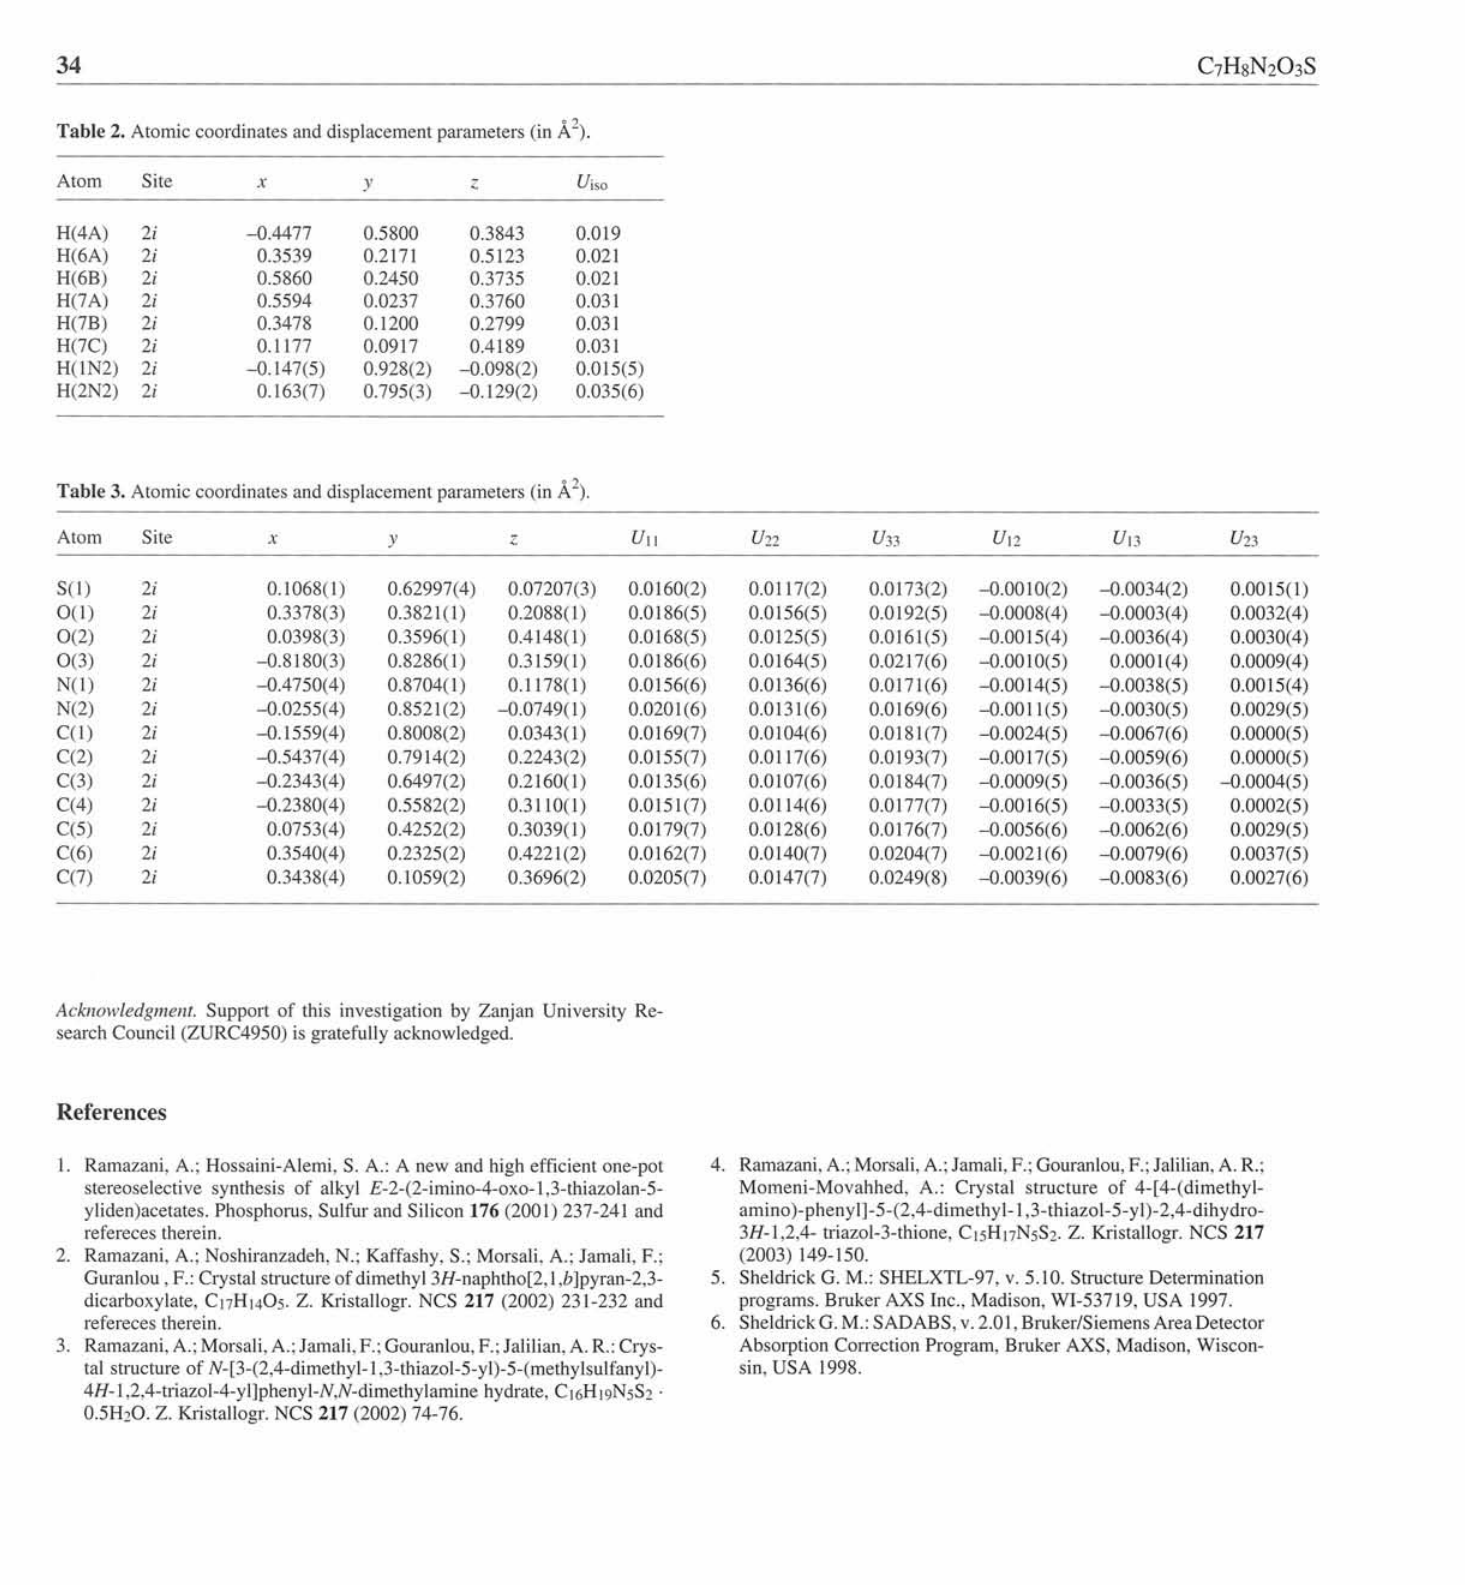
Table 3. Atomic coordinates and displacement parameters (in